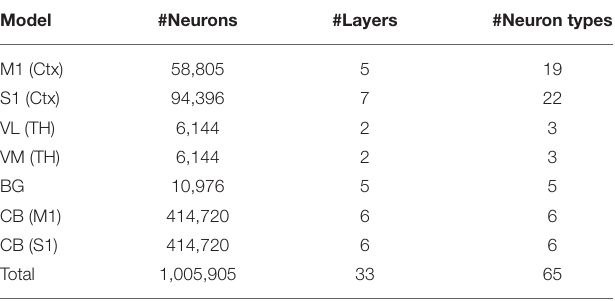
TABLE 1 | Summary statistics of the 1 × 1mm 2 unit of the rodent brain model.